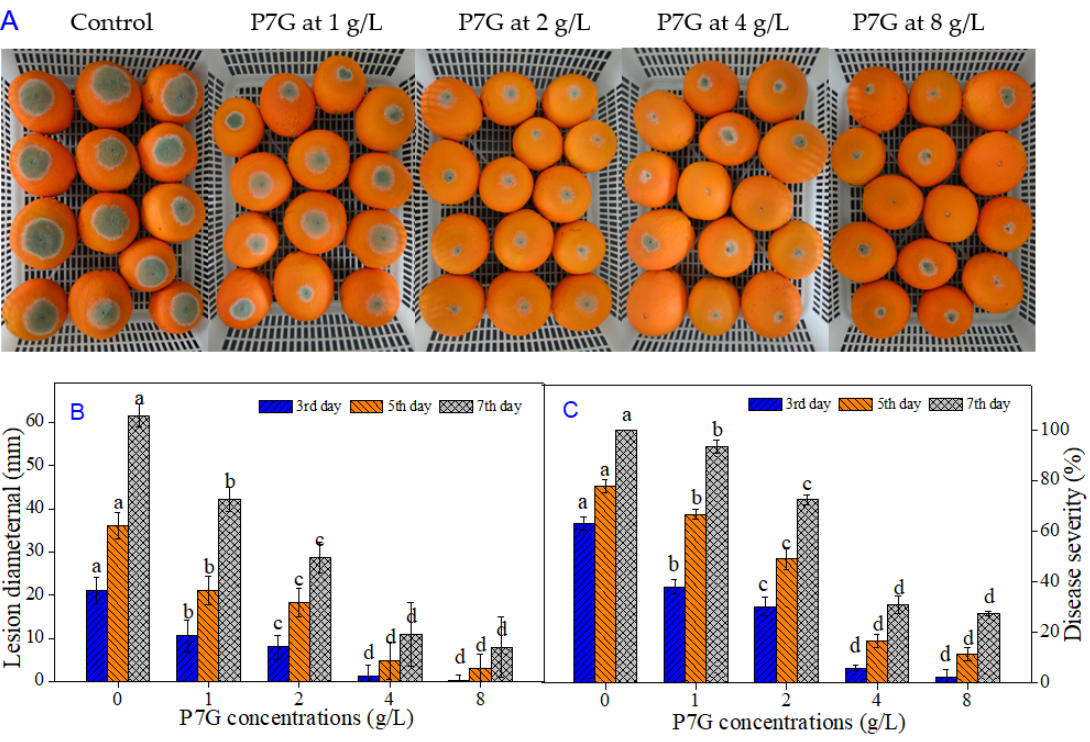
Figure 3. E ff ects of P7G at concentrations of 1–8 g / L on blue mold disease development of “Newhall” navel oranges wounds inoculated with P. italicum . Lesion diameter ( B ) and disease severity ( C ) were measured after 3, 5, and 7 days of incubation at 25 ◦ C. Each column is the mean of three replicates (10 oranges per replicate), and vertical bars represent the standard error (S.E.). The columns with di ff erent lowercase letters among each concentration at each time point are significantly di ff erent according to Duncan’s test at p <